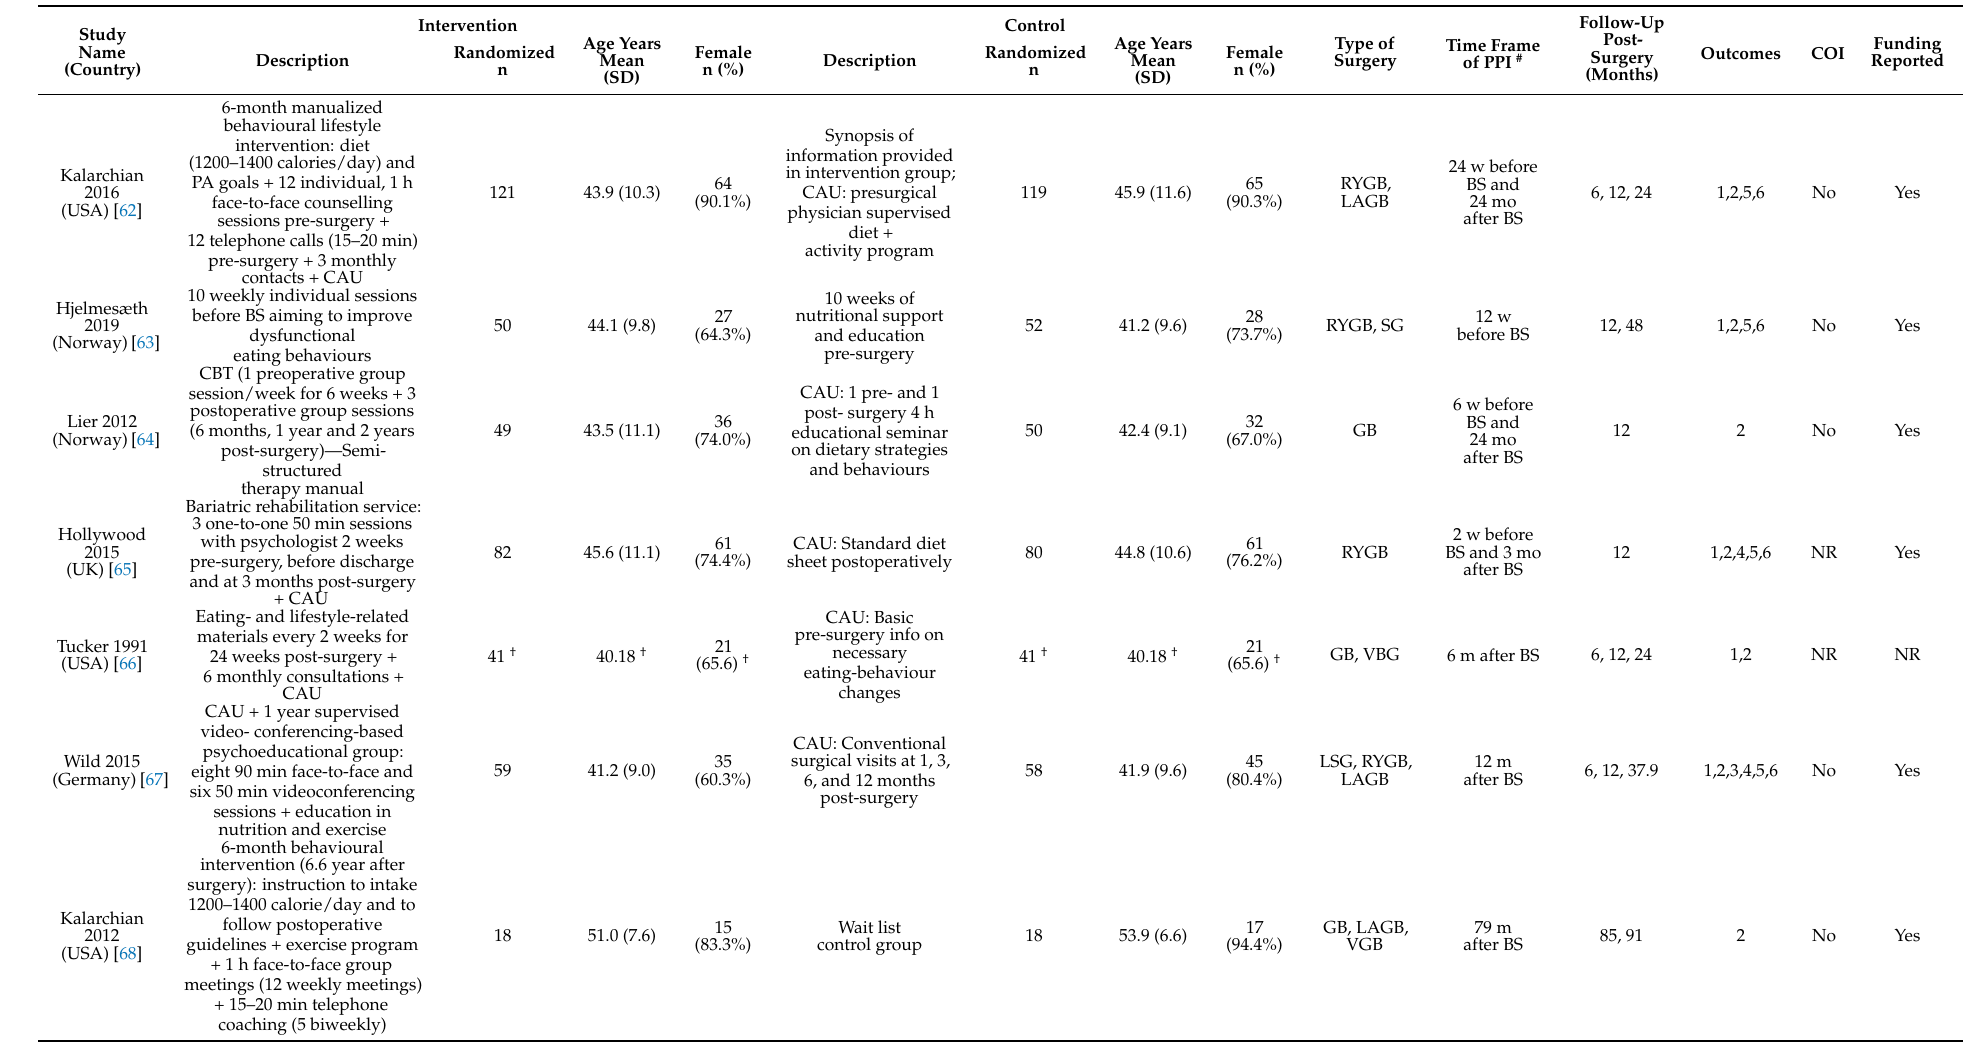
Table 1. Characteristics of included